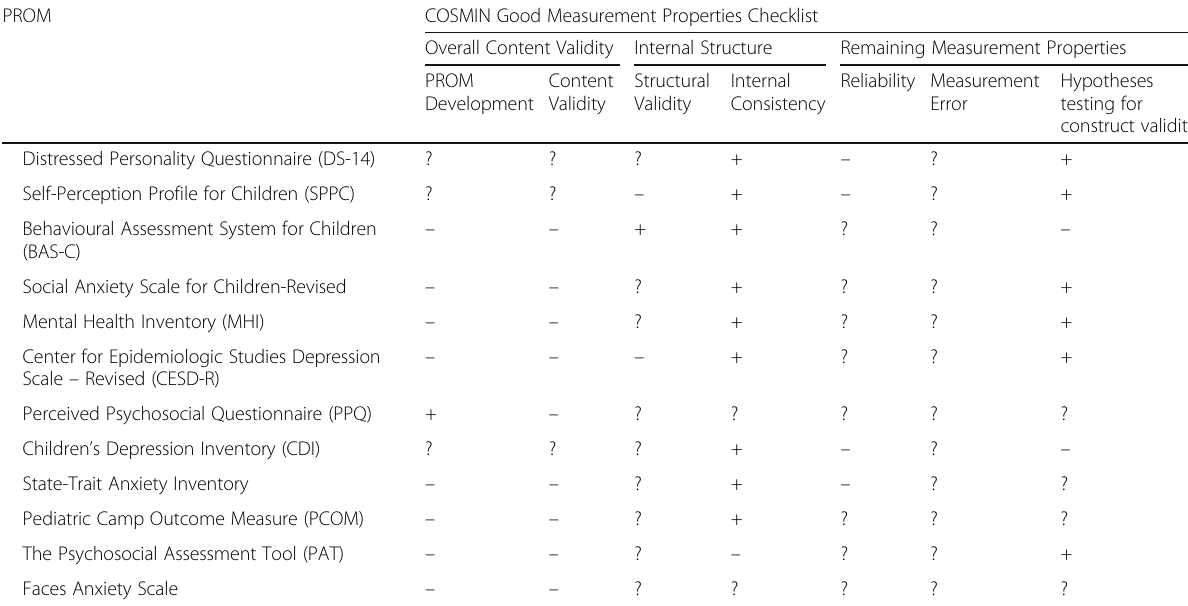
Table 1 Quality analysis of all identified PROMs ( n = 100). The COSMIN ‘ good property checklist ’ was applied on 100 PROMs, across 7 measurement properties stratified by construct. PROMs were ranked highest score of sufficient quality to lowest, within a construct. ‘ + ’ indicates a score of sufficient quality, ‘ ? ’ indicates that the specific measurement property was not reported on, and ‘ - ’ indicates insufficient quality